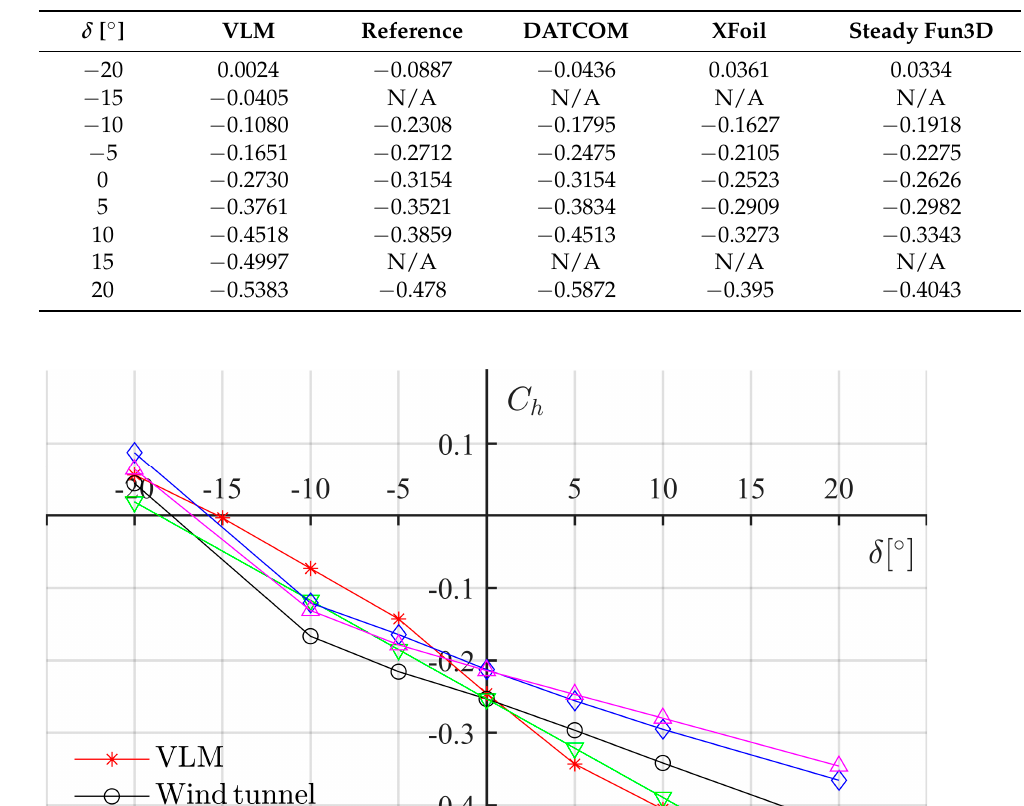
Figure A3. Table A3. Comparison of C h for GA(W)-1 at alpha 16 ◦ .